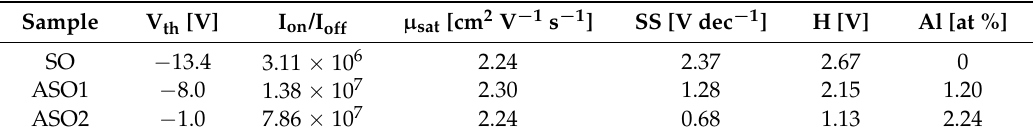
Table 1. Electrical parameters revealed by the thin-film transistor (TFT) transfer curves scanned with forward bias sweep, hysteresis (H) in clockwise direction and Al atomic concentrations from X-ray photoemission spectroscopy (XPS) spectral analyses.